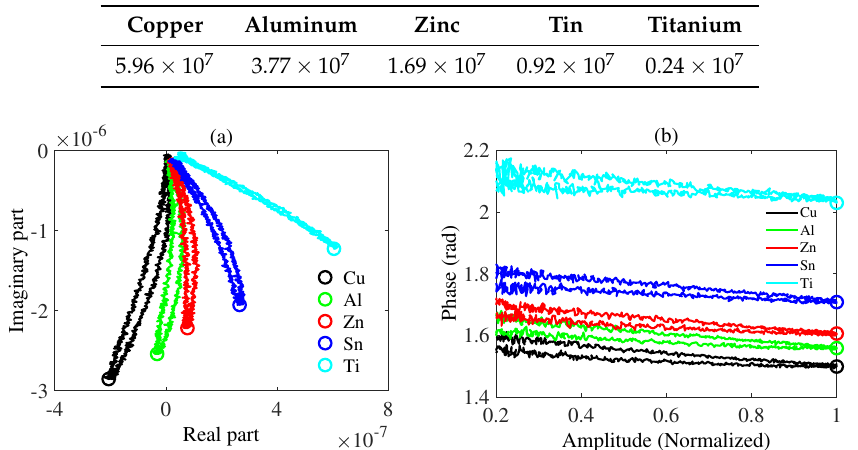
Table 1. Conductivity (S/m) of metals.